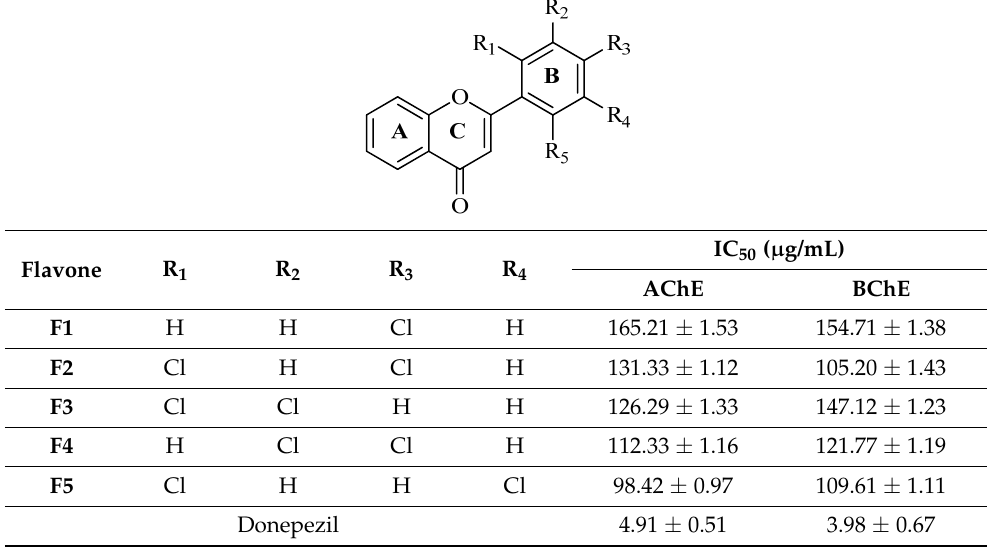
Table 1. Synthesized flavones with IC 50 values against cholinesterase enzymes.